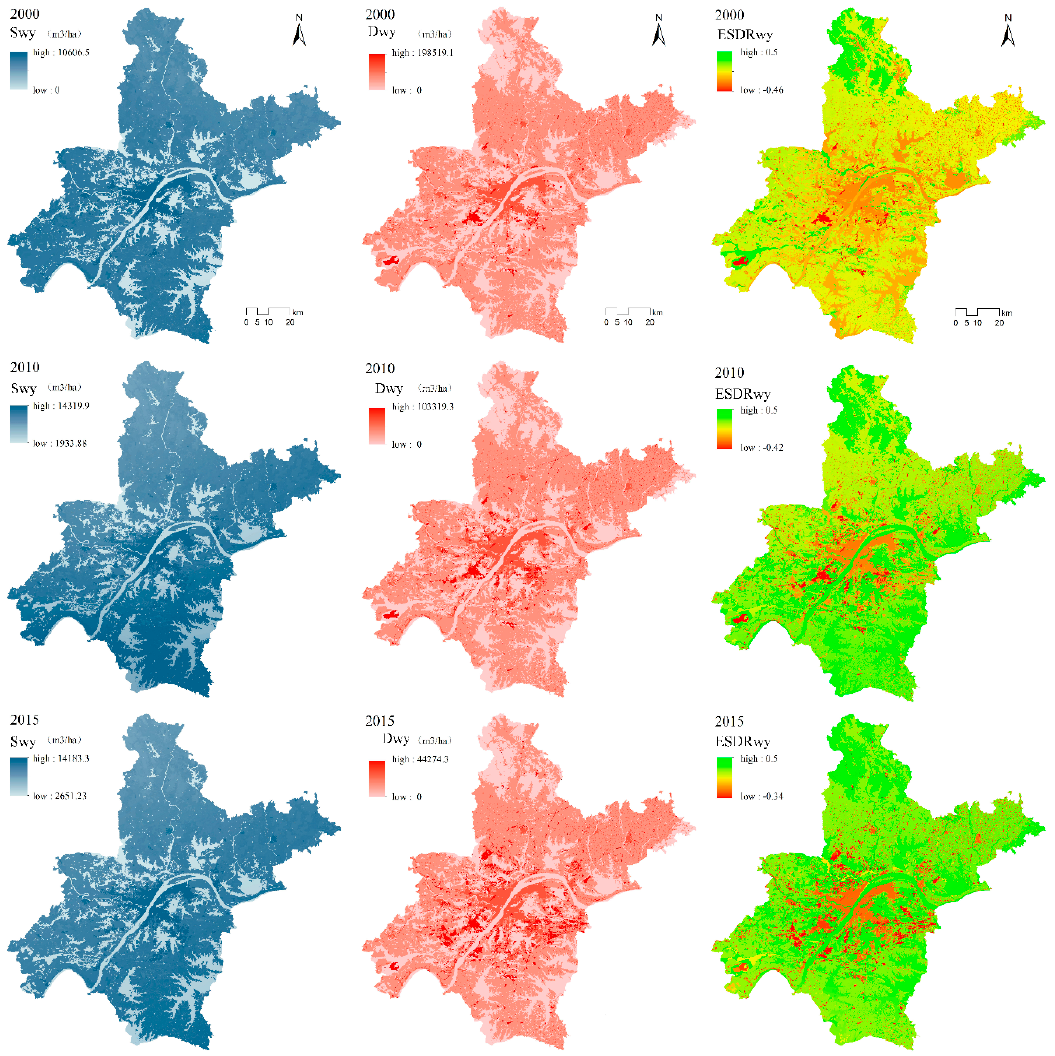
Figure 2 . Spatial distribution of supply, demand, and supply–demand ratio of water yield service in Wuhan in 2000, 2010, and 2015.